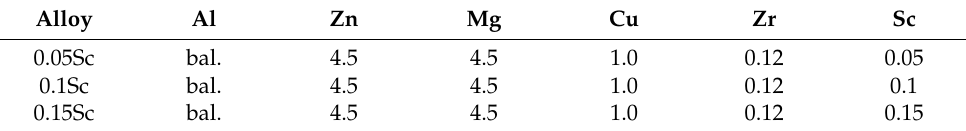
Table 1. Chemical composition of the investigated alloys (wt.